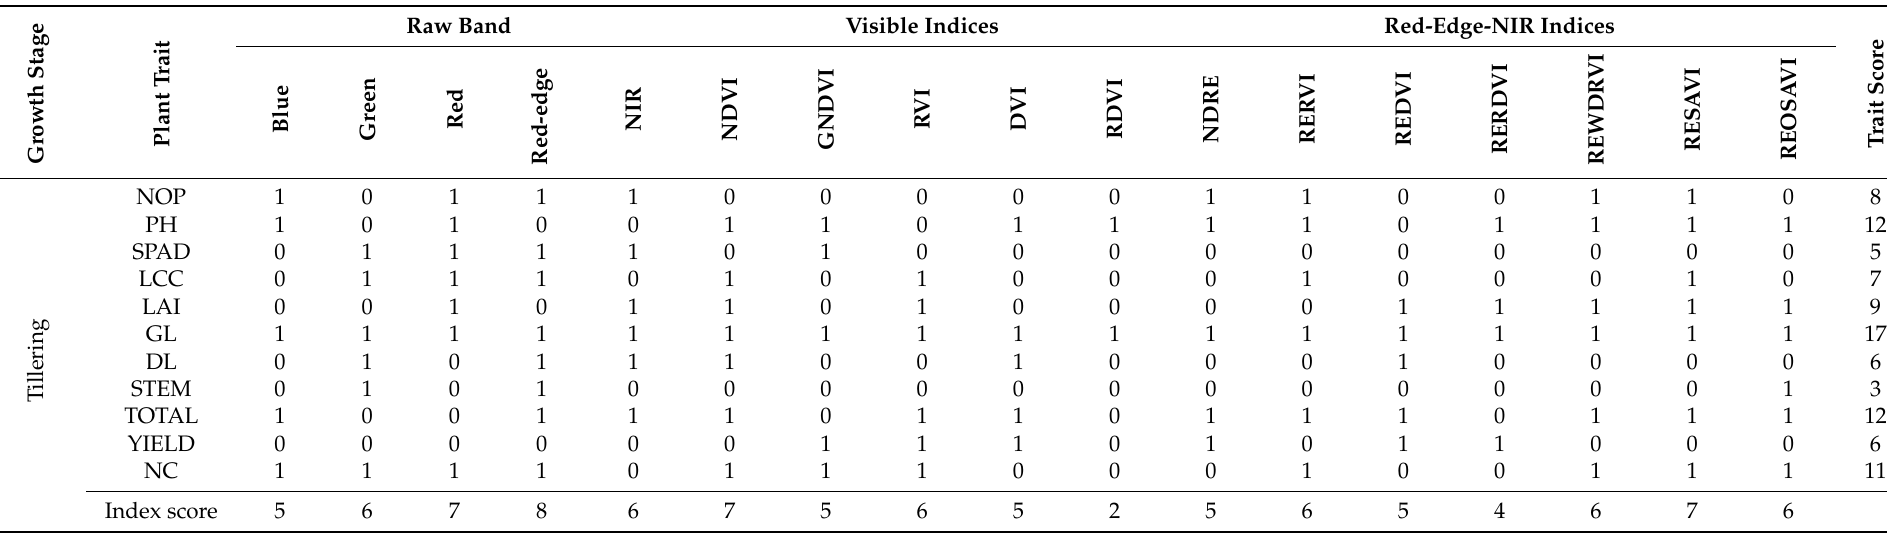
Table 4. Index and trait score for all plant traits and indices at